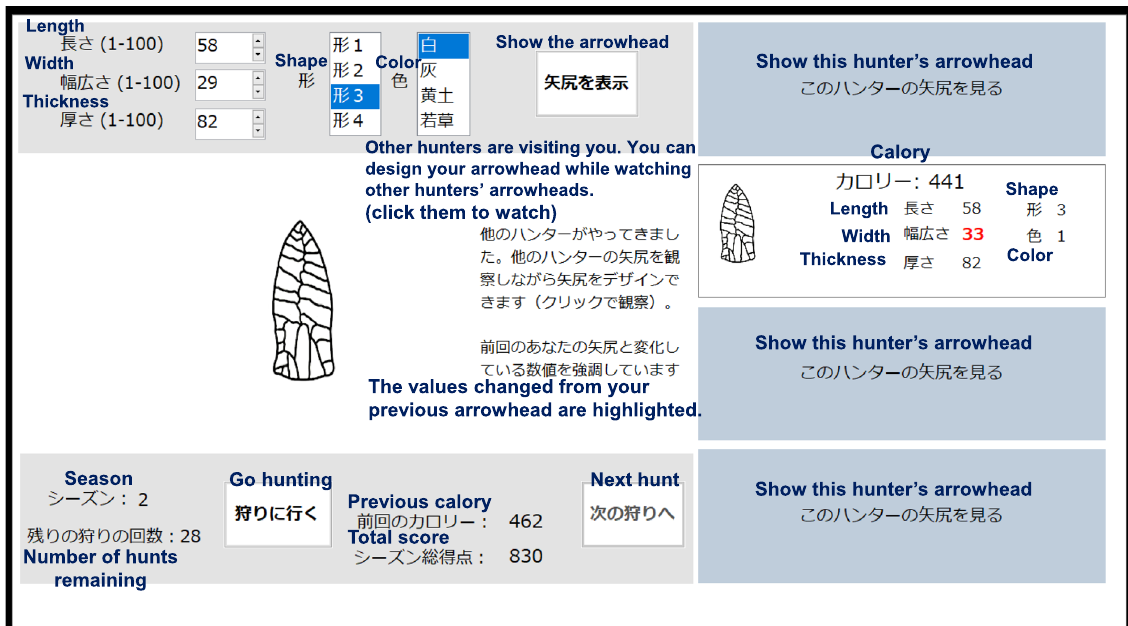
Figure 4. A sample screenshot of the experimental screen (negative social learning condition). English translations of labels are